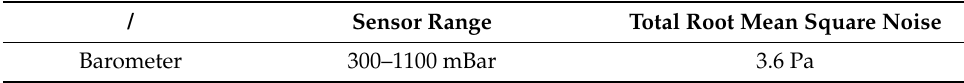
Table 5. Performance parameter of XSENS